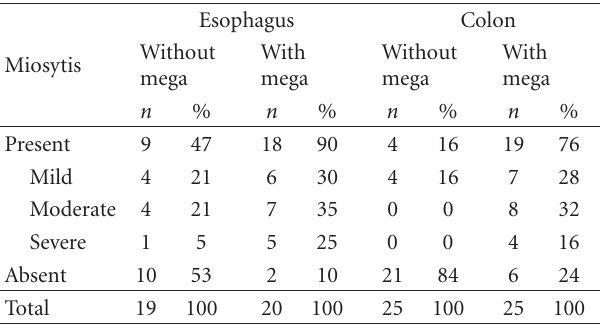
Table 1: Distribution of cases according to study groups and intensity of myositis in esophagus and colon with or without